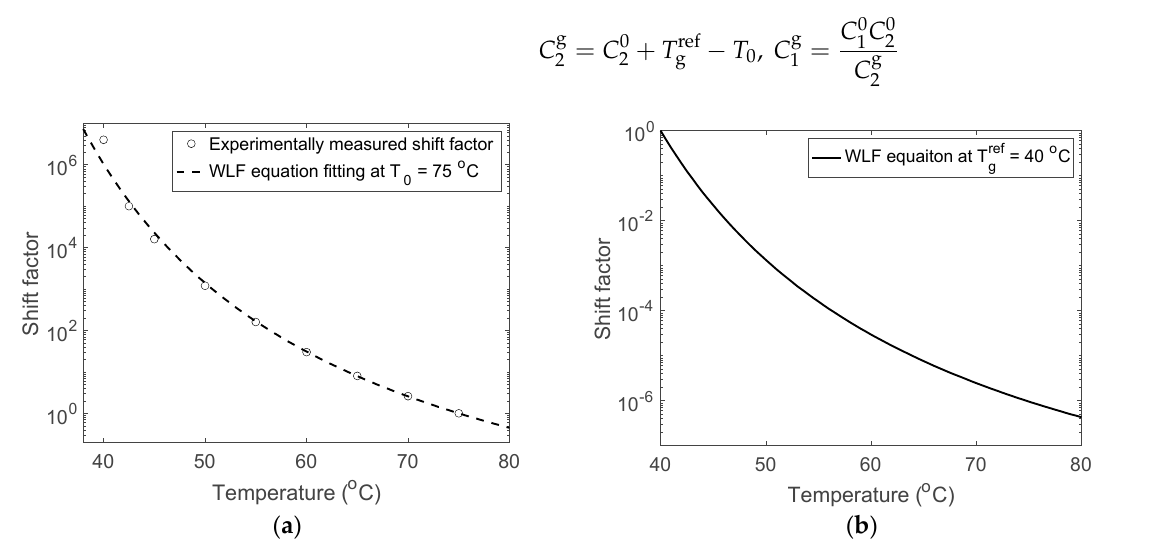
Figure 2. The temperature-dependent shift factor a T ( T ) for dry polymers with 2 wt.% crosslink density at ( a ) the reference temperature T 0 and ( b ) the glass transition temperature T ref g . Table 2. Parameters of Williams–Landel–Ferry (WLF) constants for polymers with 2 wt.% crosslink density. Parameter